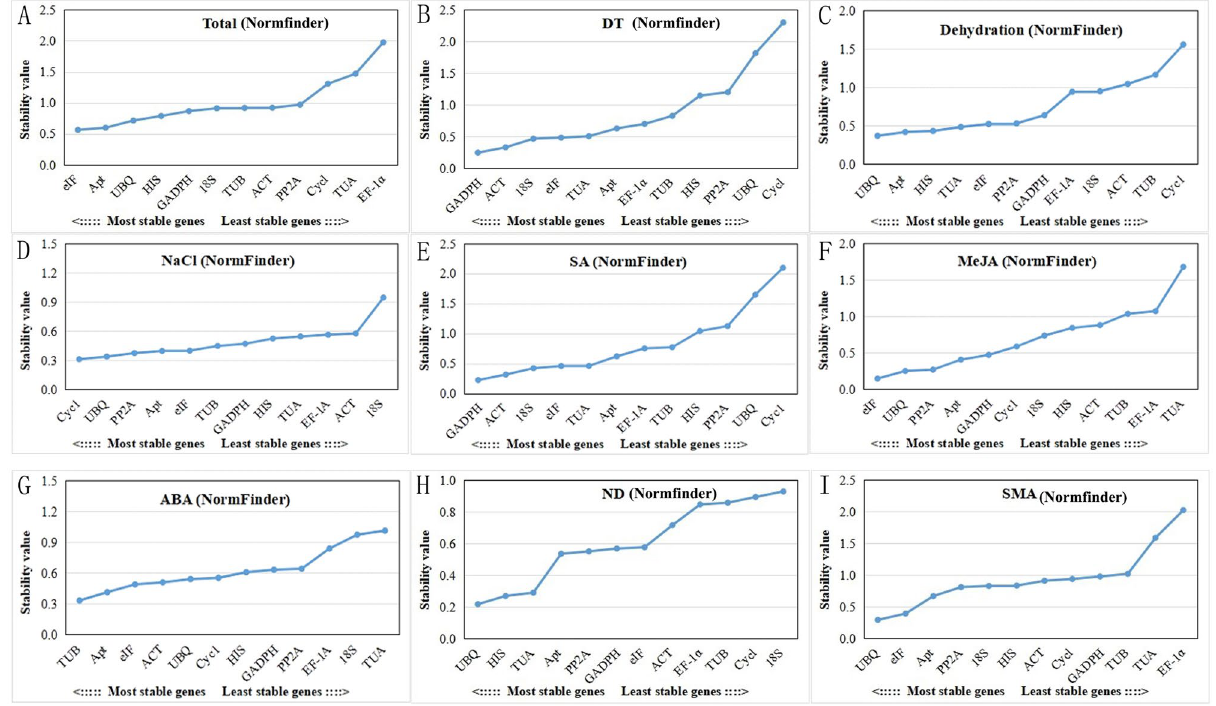
Figure 5. NormFinder-based expression stability evaluation of 12 candidate reference genes. ( A ) Total: the set of total samples. ( B ) DT: the set with the samples of different tissues. ( C ) Dehydration treatment samples. ( D ) NaCl treatment samples. ( E ) SA treatment samples. ( F ) MeJA treatment samples. ( G ) ABA treatment samples. ( H ) ND: the set with the samples of NaCl and dehydration treatments. ( I ) SMA: the set with the samples of SA, MeJA, and ABA treatments.